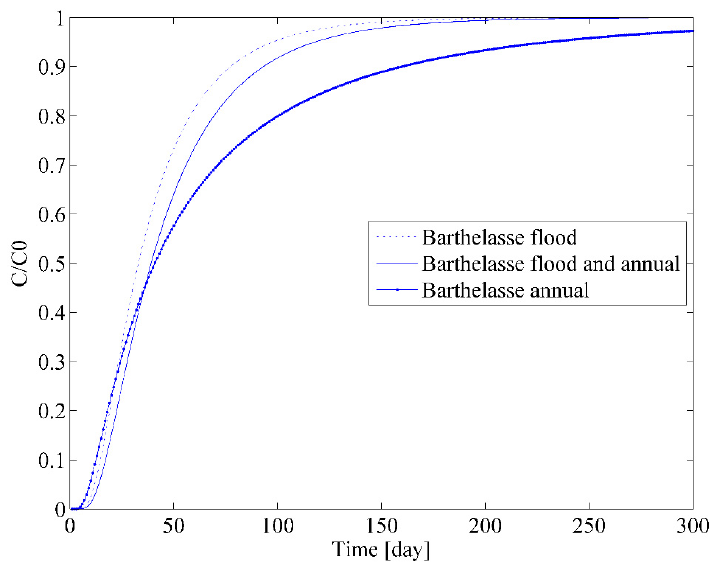
Figure 17. C/C0 as a function of time in each of the study cases in Barthelasse. As the distance between two observations wells and the Rh ô ne is known along the same flow line, it is possible to calculate the effective water velocity in the aquifer’s saturated zone. The actual velocities were calculated for three transects, Rh ô ne-backfill, Rh ô ne-Barthelasse and backfill-Barthelasse (98 m) with the three model’s analyses (Table 3). The average velocity is of the order of 3 m/d, with a high variability according to the models. For the three transects, the highest velocity is always estimated from the “flood” model. The average velocity on the backfill-Barthelasse section is higher than that estimated on the Rh ô ne-backfill section for two out of three models. The average velocity is in the same order when referring to the combined model. From the calculated Dp values, it is possible to estimate the dispersivity on the Rh ô ne-backfill transect and on the Rh ô ne- Barthelasse transect. This gives values of α = 14 m for the Rh ô ne-backfill transect and α = 43 m for the Rh ô ne-Barthelasse transect. The values obtained are consistent with the scale of the system studied. These differences in velocities between the two transects can be explained by the difference in the composition of the environment between the backfill and the Barthelasse pumping field area. The backfill is made up of a mixture of coarse and fine materials reconstituted by the dredging of the river, constituting a heterogeneous